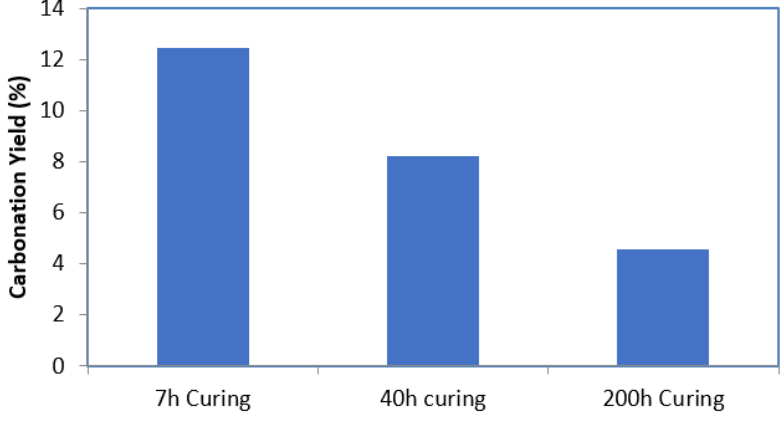
Figure 11. Influence of curing time on carbonation yield.